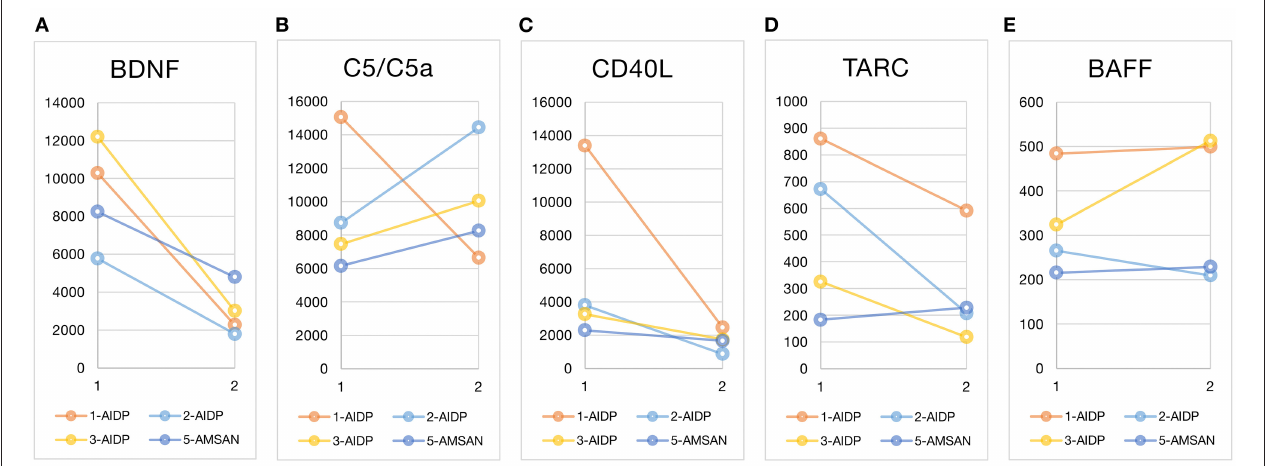
FIGURE 1 | Before and after treatment plasma cytokine changes. Luminex multiplexing assay measured the five cytokines at two time points: at GBS diagnosis (before treatment) and after immunotherapy. The line graphs marked the before–after cytokine changes of each patient (the x-axis time point 1 for before treatment and 2 for after treatment). The unit of cytokines was µ g/mL. The case number and type of GBS variants are listed in the graphic legend. Case 4 was excluded from the cytokine comparisons because of the obvious paraneoplastic nature of GBS in this case and the heterogeneity from other nonparaneoplastic GBS. BDNF, brain-derived neurotrophic factor; C5/C5a, the activated complement component C5 and C5a; CD40L, CD40 ligand; TARC, thymus and activation regulated chemokine; BAFF, B-cell–activating factor; AIDP, acute inflammatory demyelinating polyradiculoneuropathy; AMSAN, acute motor-sensory axonal